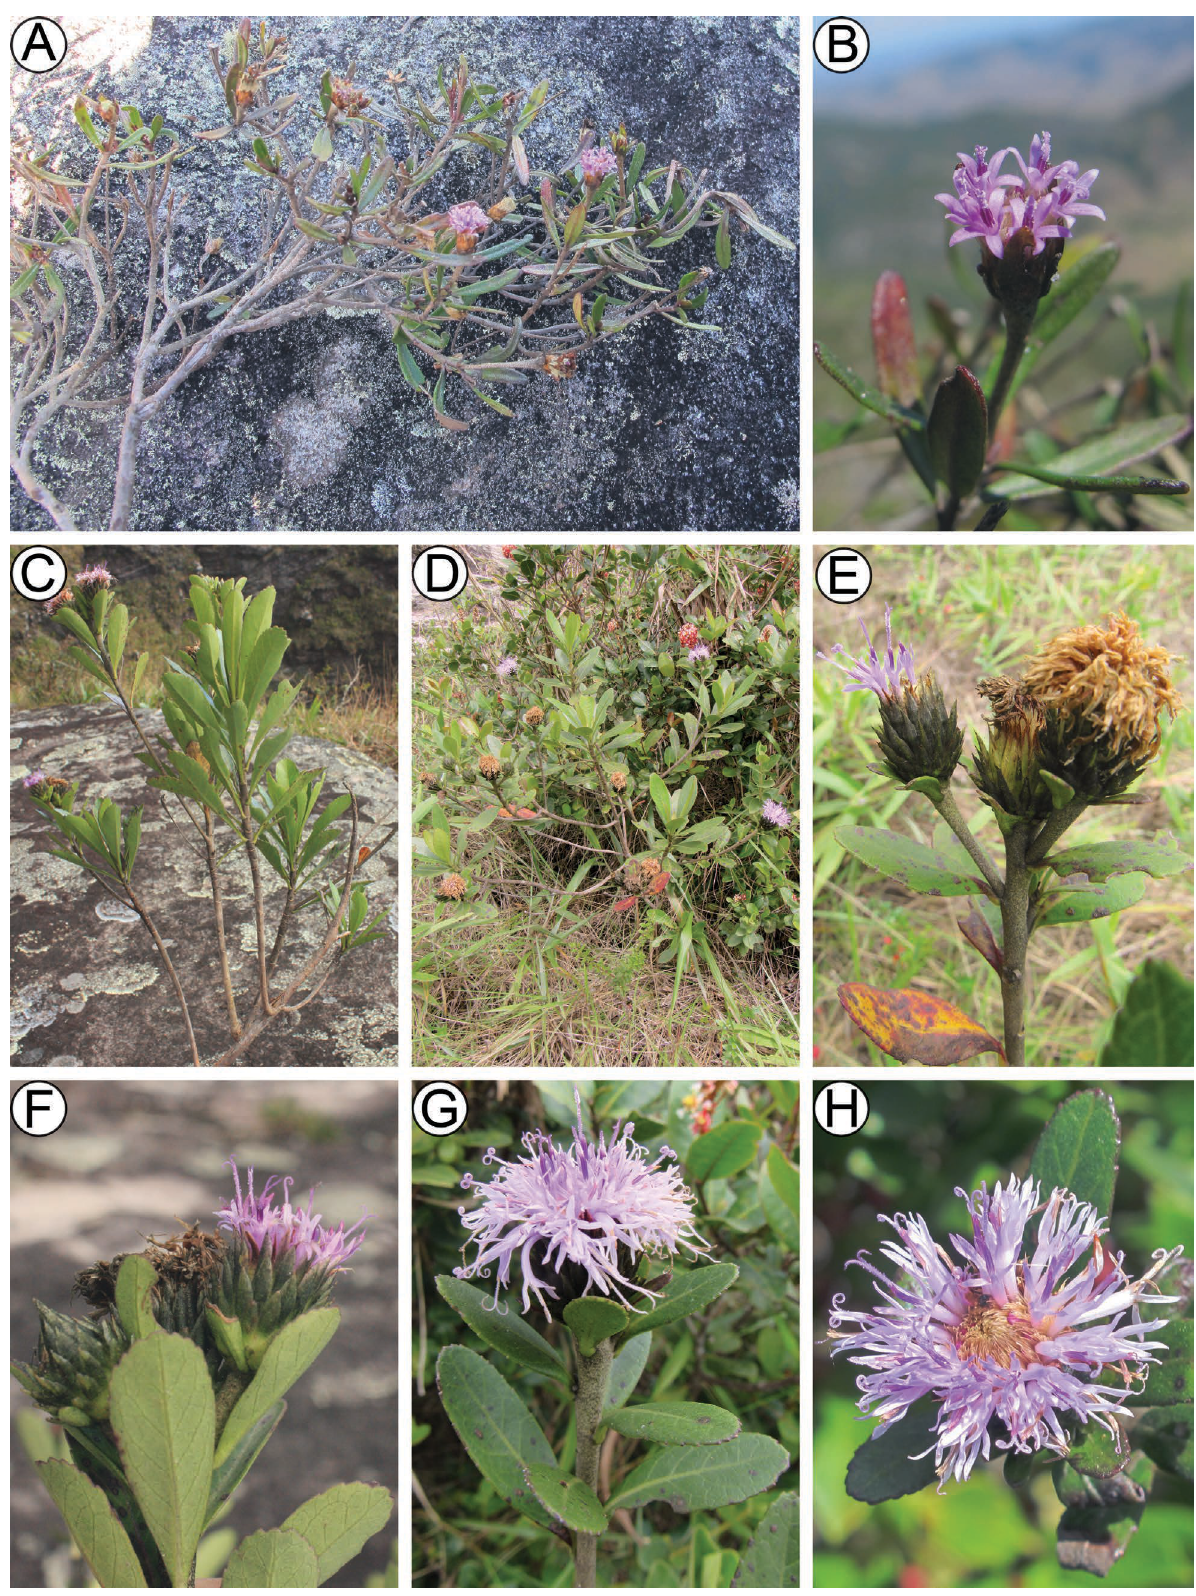
Figure 5 – A – B . Lessingianthus petraeus Antar & Loeuille, A . Habit. B . Detail of capitulum. C – H . Lessingianthus squamosus M.Monge & Semir C – D . Habit. E – F . Inflorescence. G . Capitula with florets at anthesis, side view. H . Capitula with florets at anthesis, viewed from above. Photographs: A–B by Benoit Loeuille, C–F by Carolina M. Siniscalchi, G–H by Paulo M.